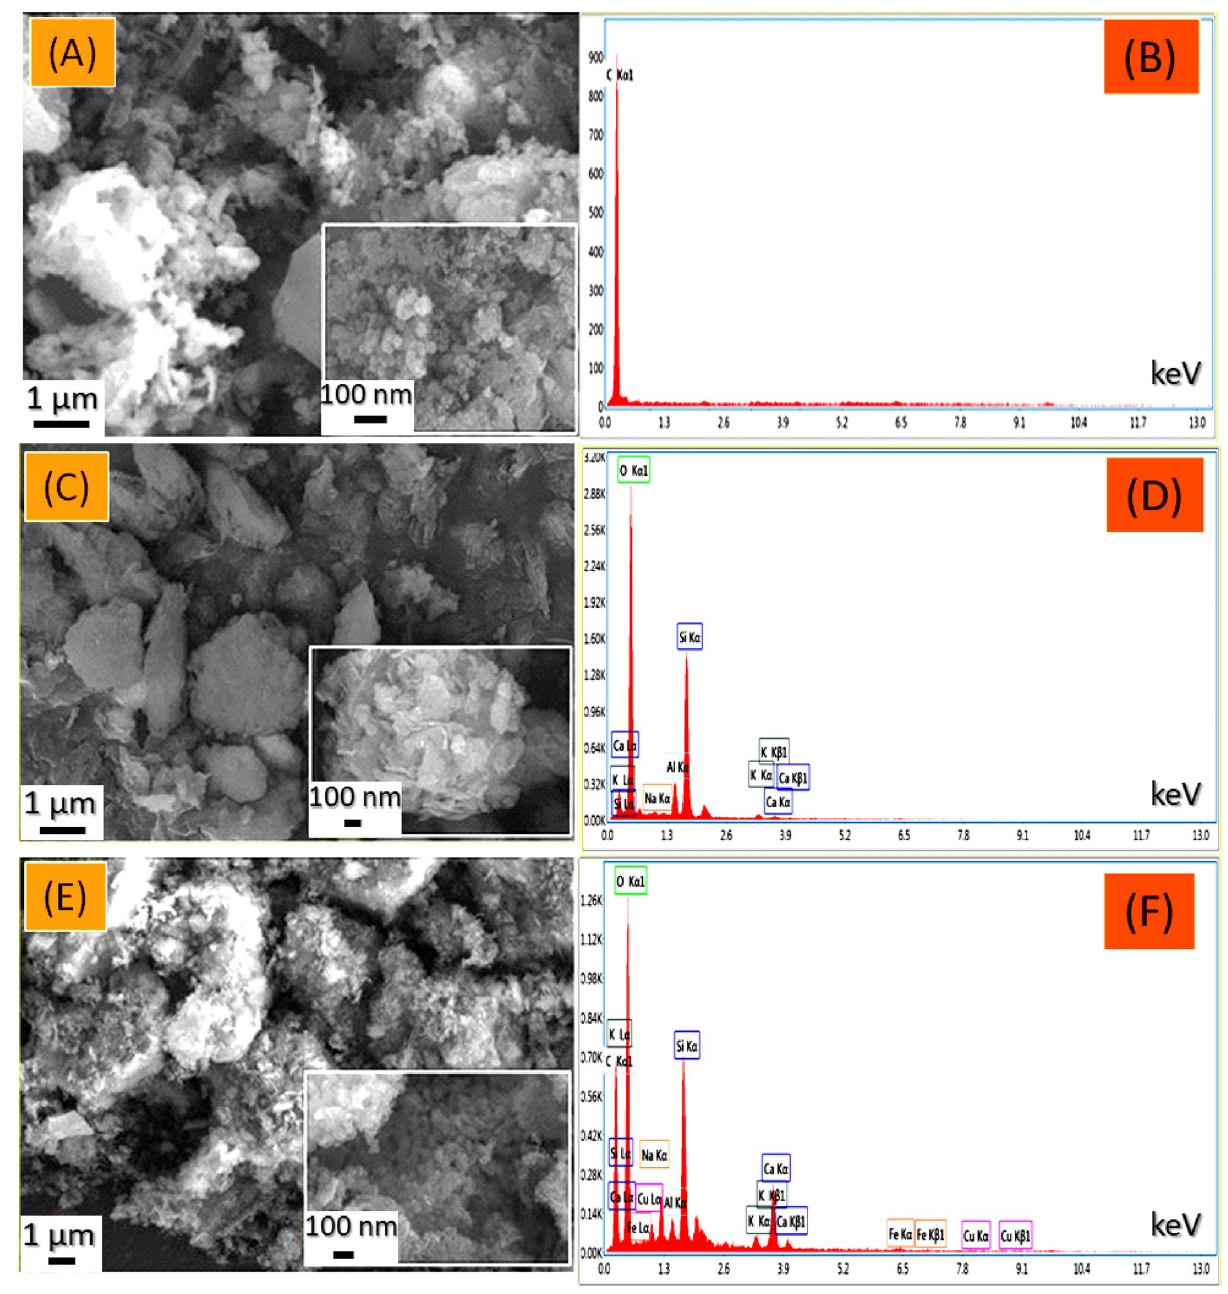
Figure 4. SEM images and EDX elemental analysis of ( A , B ) AC500, ( C , D ) NZ, and ( E , F ) under ultrasonic for 120 min. after that, 3 mL of the suspension sample in a cuvette was used for absorbance measurement 3 . The optical absorbance spectra of the prepared AC500, AC700, AC900, and AC500/NZ were measured as shown in Fig. 5. All nanopowder showed a strong absorption band in the UV range below λ = 350 nm. This band results from an electron jump from the valence band to the conduction band (CB). Then, the absorption decreases rapidly as a function of the wavelength in the visible and NIR region. For AC nanopowders, the absorption intensities overall ranges are decreased with increasing the carbonization temperature from 500 to 900 °C. The AC500/NZ nanocomposite sample has high absorption intensity compared to other nanopowders. This is due to the interac- tion between AC500 and NZ leading to modification of the electronic structure. Hence, NZ has improved the visible light absorption capability of the AC500 nanopowder. It is observed from Fig. 5 that the absorption edge is shifted lower higher wavelength with increasing the temperature from 500 to 900 °C. As a result, the sample AC500/NZ has a wide absorption band that extends into the visible spectrum. This indicates that this sample can absorb more photons in the visual range. The absorption coefficient (α) was calculated based on measured absorbance (A) by the next equation: